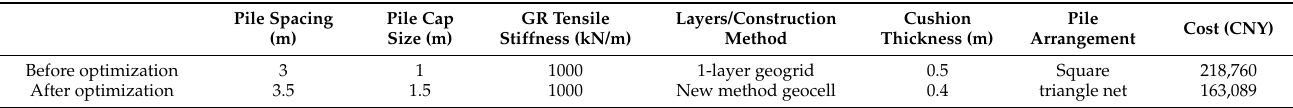
Table 9. Design details of GRPSE before and after